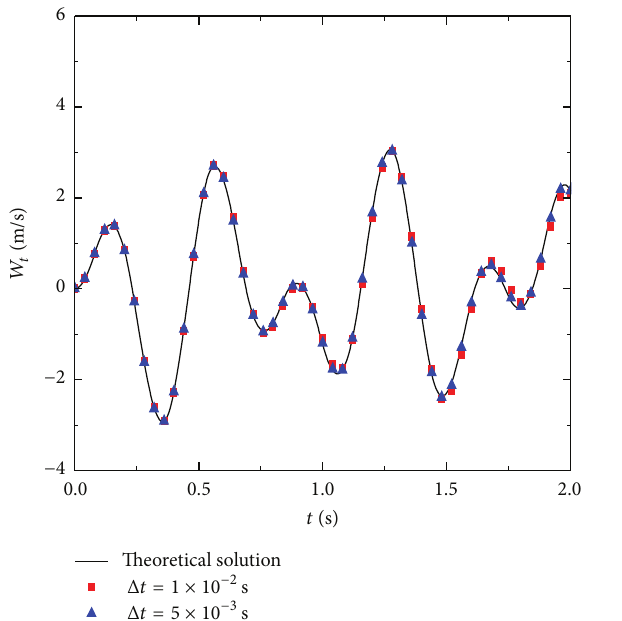
Figure 9: Numerical result of 𝜕 2 𝑊/𝜕𝑥 2 with Δ𝑡 = 5 × 10 −3